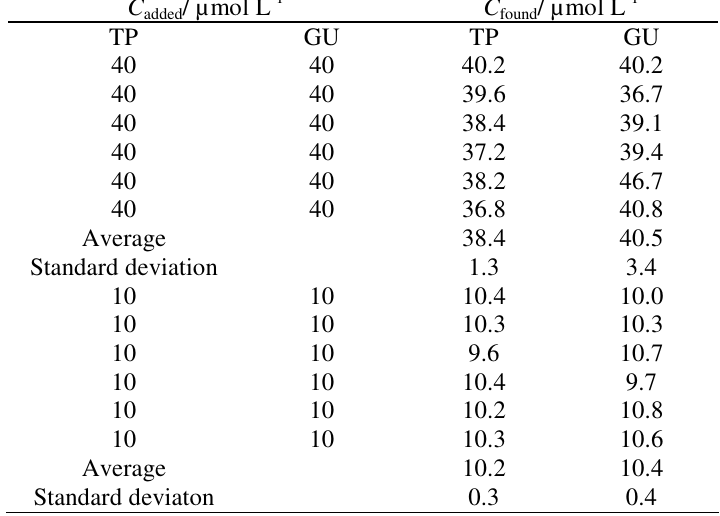
Table 2. Replicate measurements of guaifenesin and theophylline in some synthetic